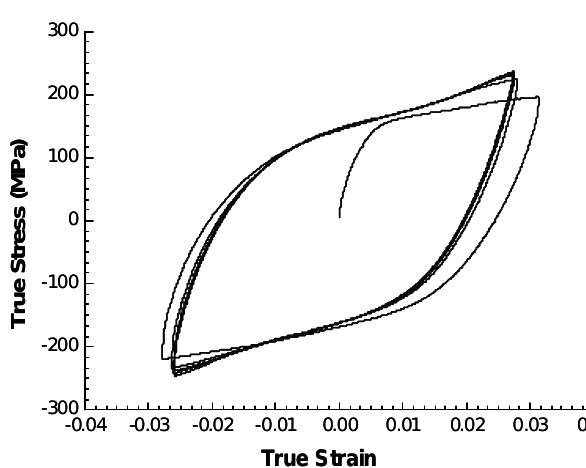
Figure 7. Cyclic stress-strain curve